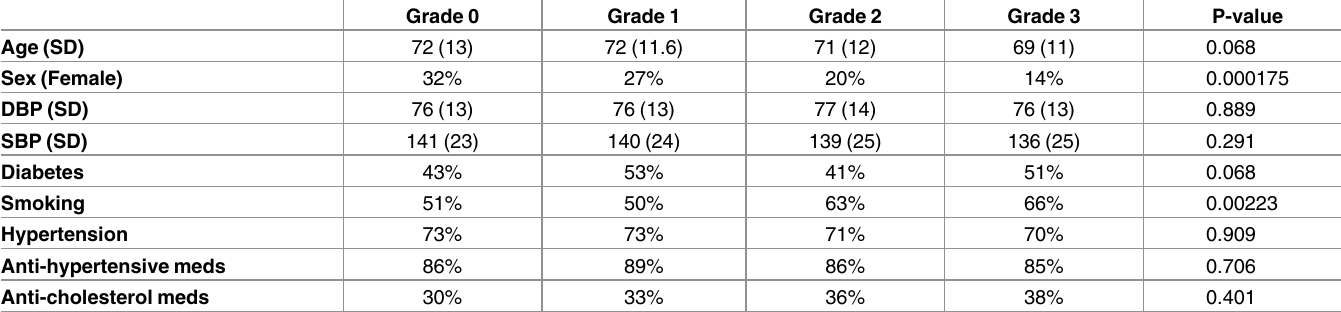
Table 1. Population demographics and clinical characteristics based on collateral grades.